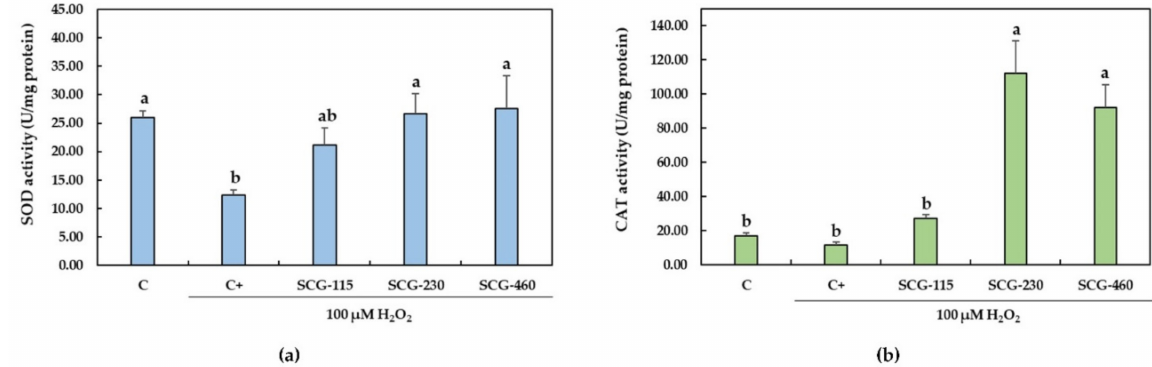
Figure 3. Effect of polyphenolic extracts from SCG on the ( a ) SOD and ( b ) CAT activities in C. viridis brain cells under H 2 O 2 -induced oxidative stress. Cells were pretreated with the SCG extracts (115–460 µ g/mL) for 24 h and then incubated in the presence of 100 µ M H 2 O 2 for 1 h. C: control, non-treated cells; C +: cells treated with 100 µ M H 2 O 2 alone; SCG: cells pretreated with the spent coffee ground polyphenolic extracts at 115, 230 and 460 µ g/mL, and treated with 100 µ M H 2 O 2 . Data are presented as means ± SD ( n = 3). Different letters (a, b, ab) indicate significant differences between the treatments ( p <